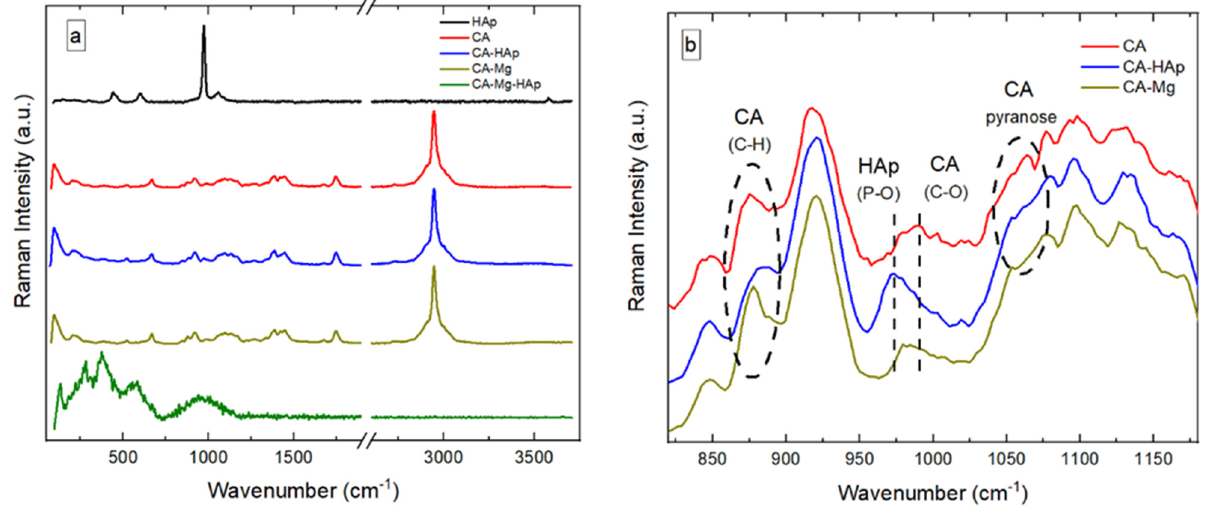
Figure 8. Raman spectra of ( a ) CA and composite samples in 800–1200 cm − 1 domain; ( b ) CA and composite samples.